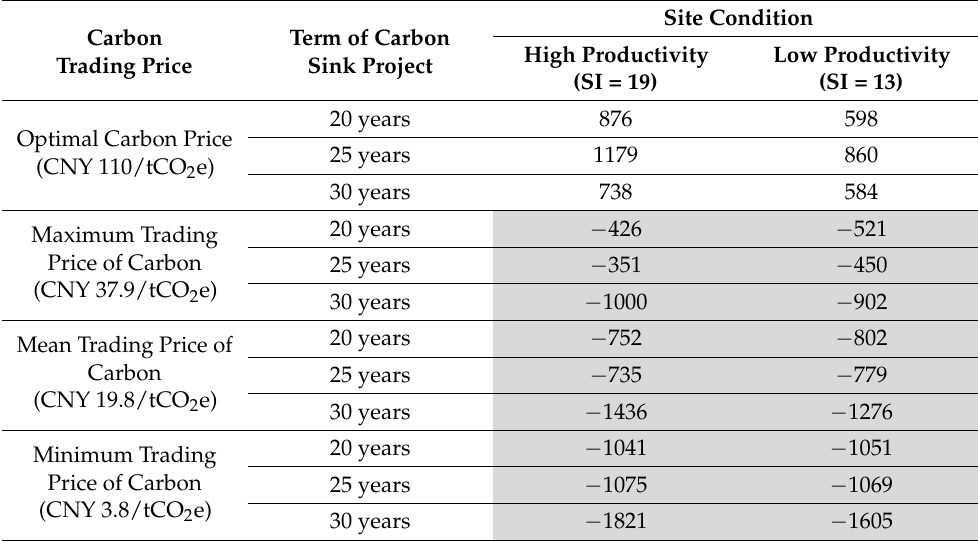
Table 2. Incremental land expectation values (net benefits) of enrolling in a larch carbon sink plantation project compared with managing the forestland for timber production in Gansu, Northwest China.